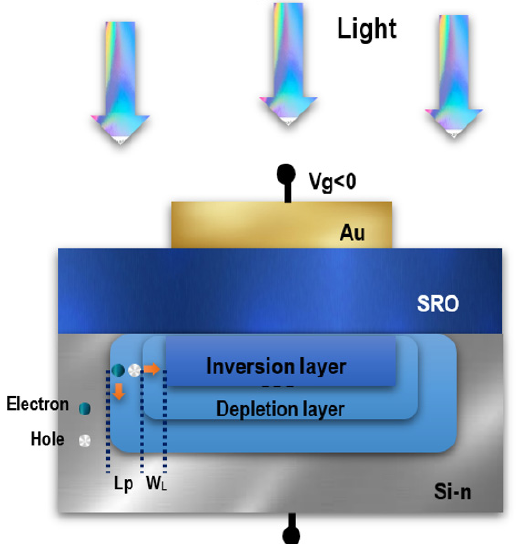
Figure 20. Schematic view of the photocarrier generation zones in the Si substrate and SRO